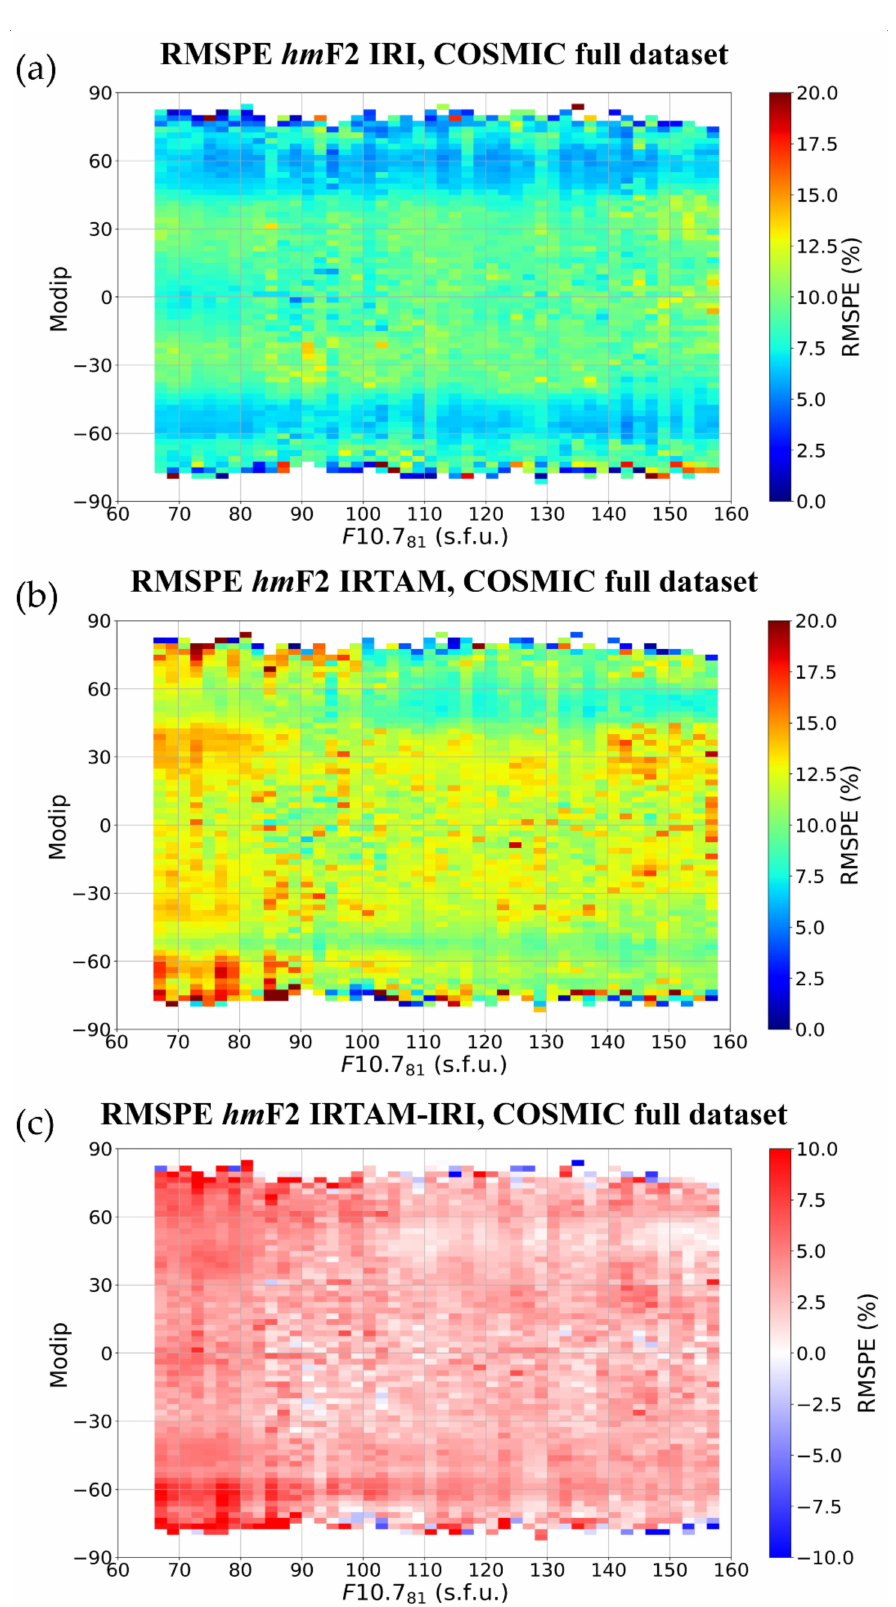
Figure 44. Same as Figure 42 but in this case data were binned as a function of the F10.7 81 solar activity index (2 sfu-wide bins) and modip (2.5 ◦ -wide